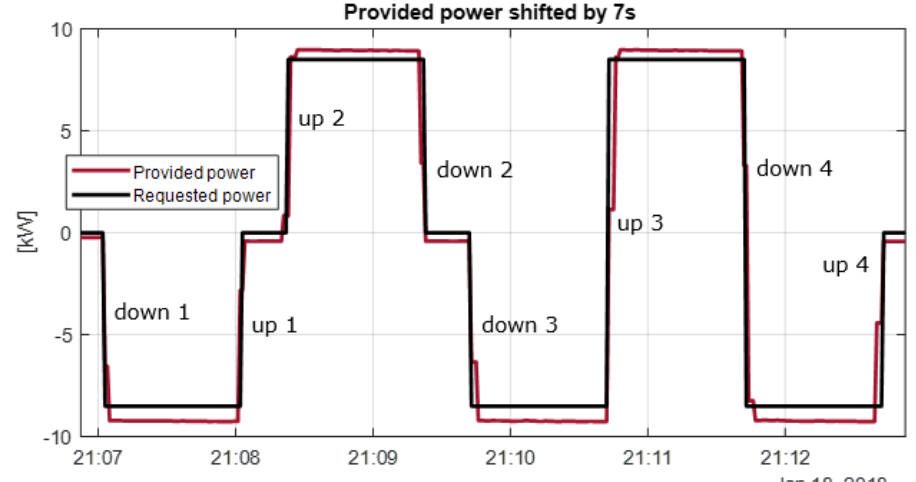
Figure 9. For each cycle of the performed performance assessment test, four events up and four events down are performed to calculate the ramping rate capability. For the step-wise portion, four cycles have been repeated.